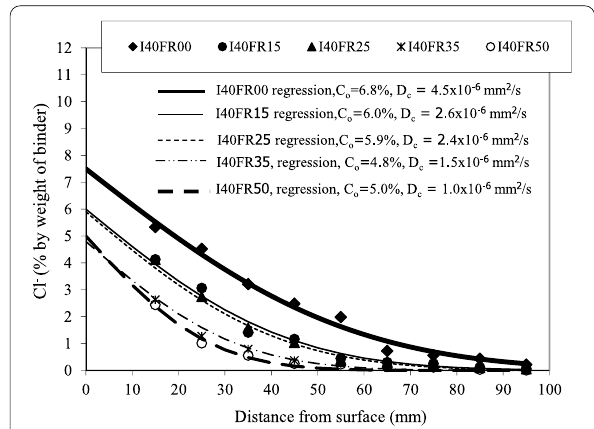
Fig. 5 Determination of D c of RCA concretes with W/B ratio of 0.40 after being exposed to seawater for 7 years.